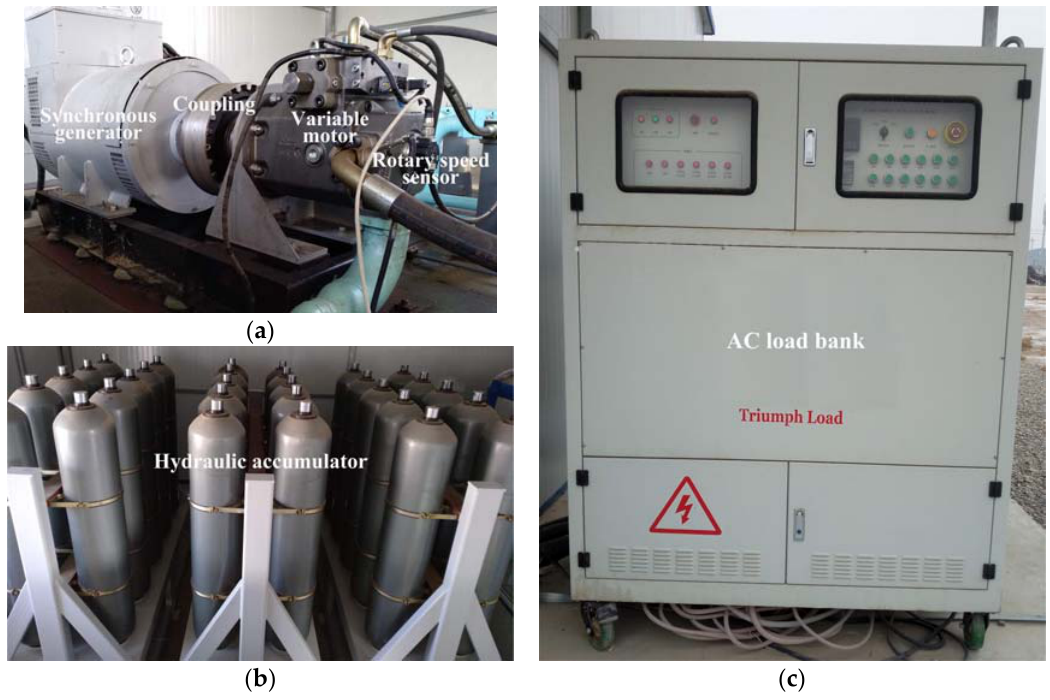
Figure 3. Photograph of the HESGS test rig. ( a ) Variable motor and generator; ( b ) Hydraulic accumulator; ( c ) Load bank.